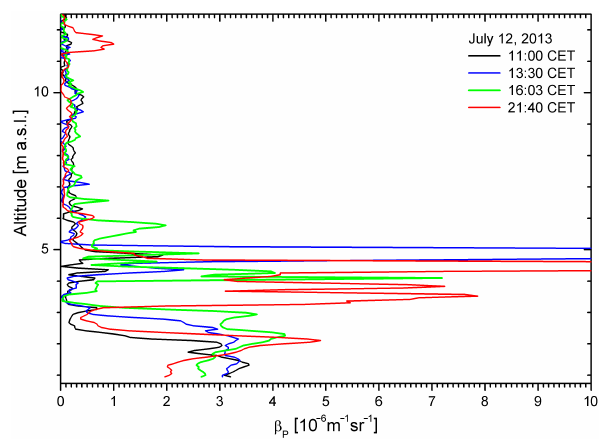
Figure 9. Ozone profiles selected from the results of 12 July 2013, and corresponding to the cases shown in Fig. 5; please note that the upper-tropospheric uncertainty is of the order of 10ppb due to the radiation loss caused by the high, lower- and mid-tropospheric ozone densities and the aerosol